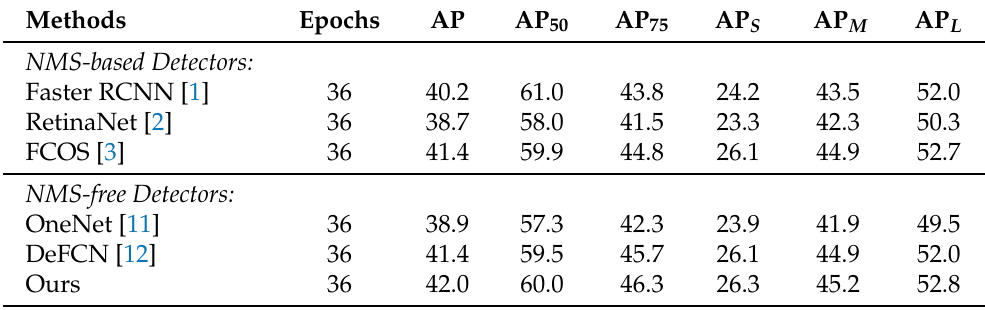
Table 1. Performance comparisons with the state-of-the-art object detectors on COCO val2017 set.